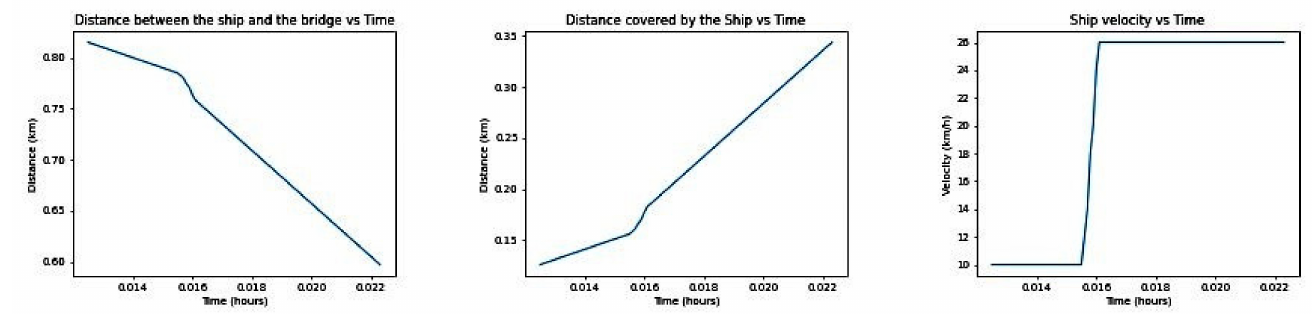
Figure 7. Graphical representation of different parameters in the designed